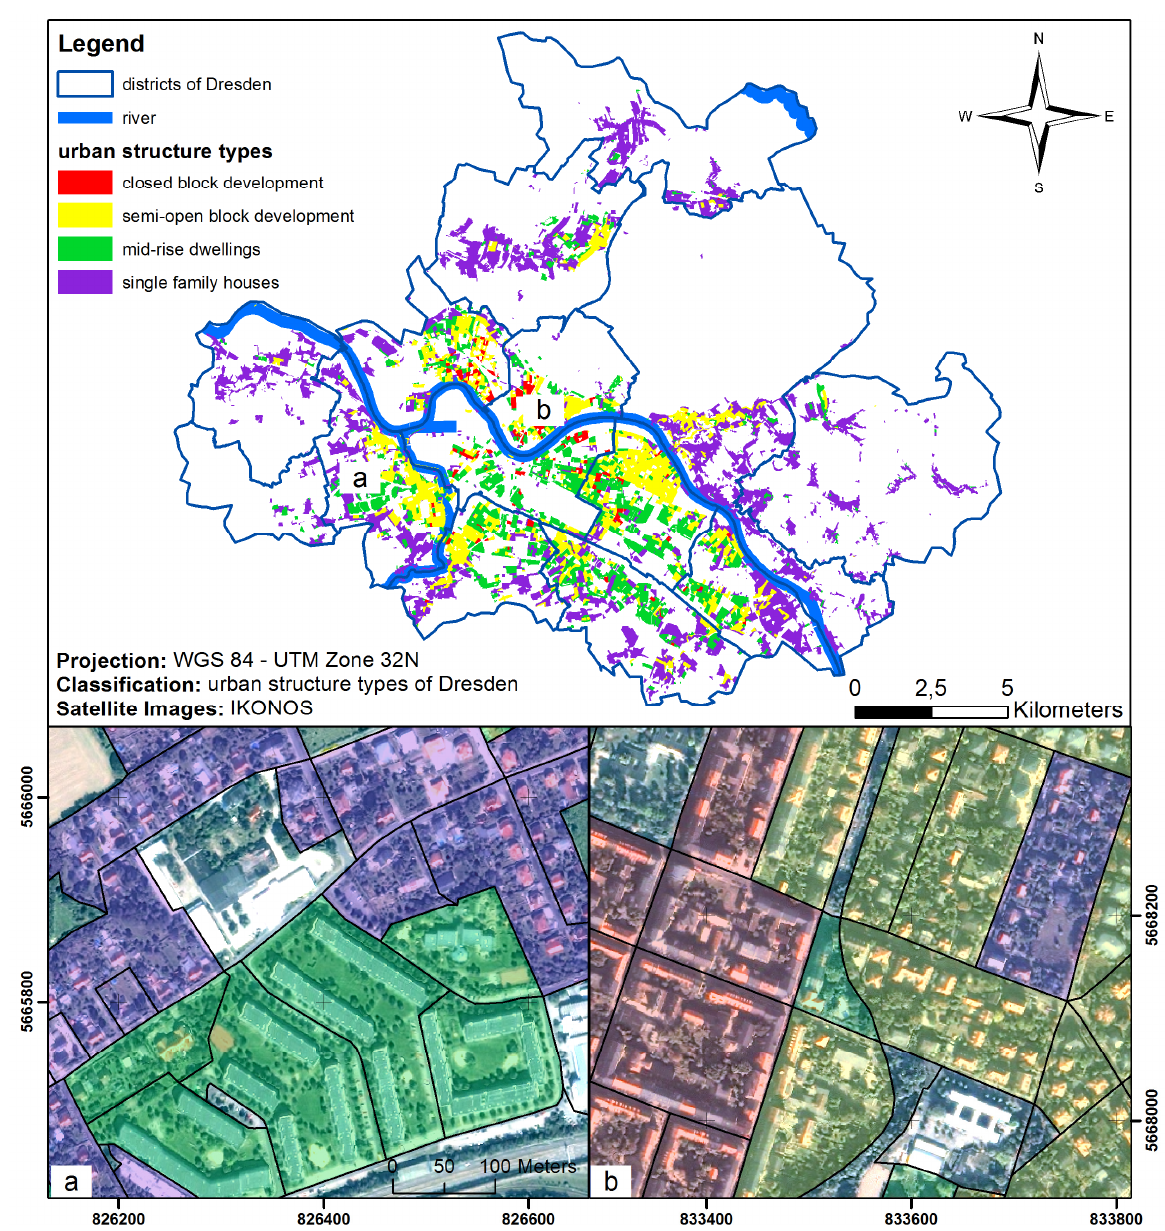
Figure 4. Urban structure types map of